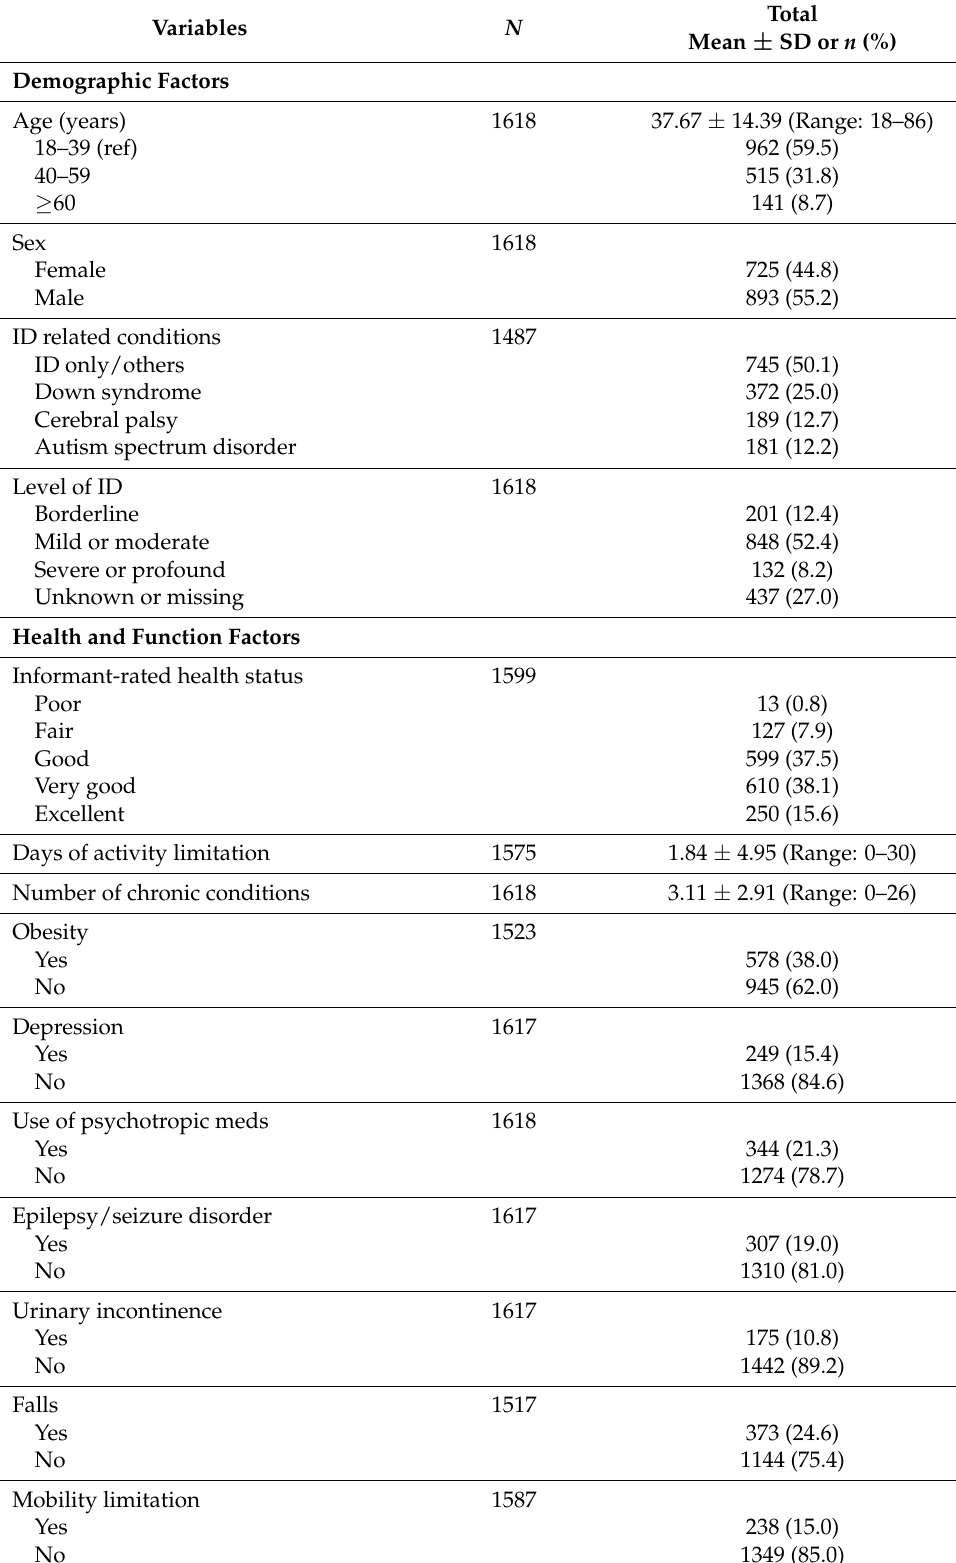
Table 1. Participant demographics and characteristics ( N = 1618). ID = intellectual disabilities; ref = a reference